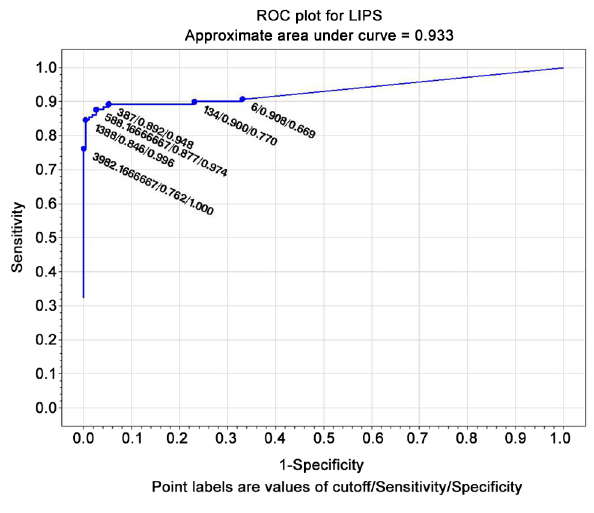
Figure 3. ROC curve for NIE-LIPS (composite reference